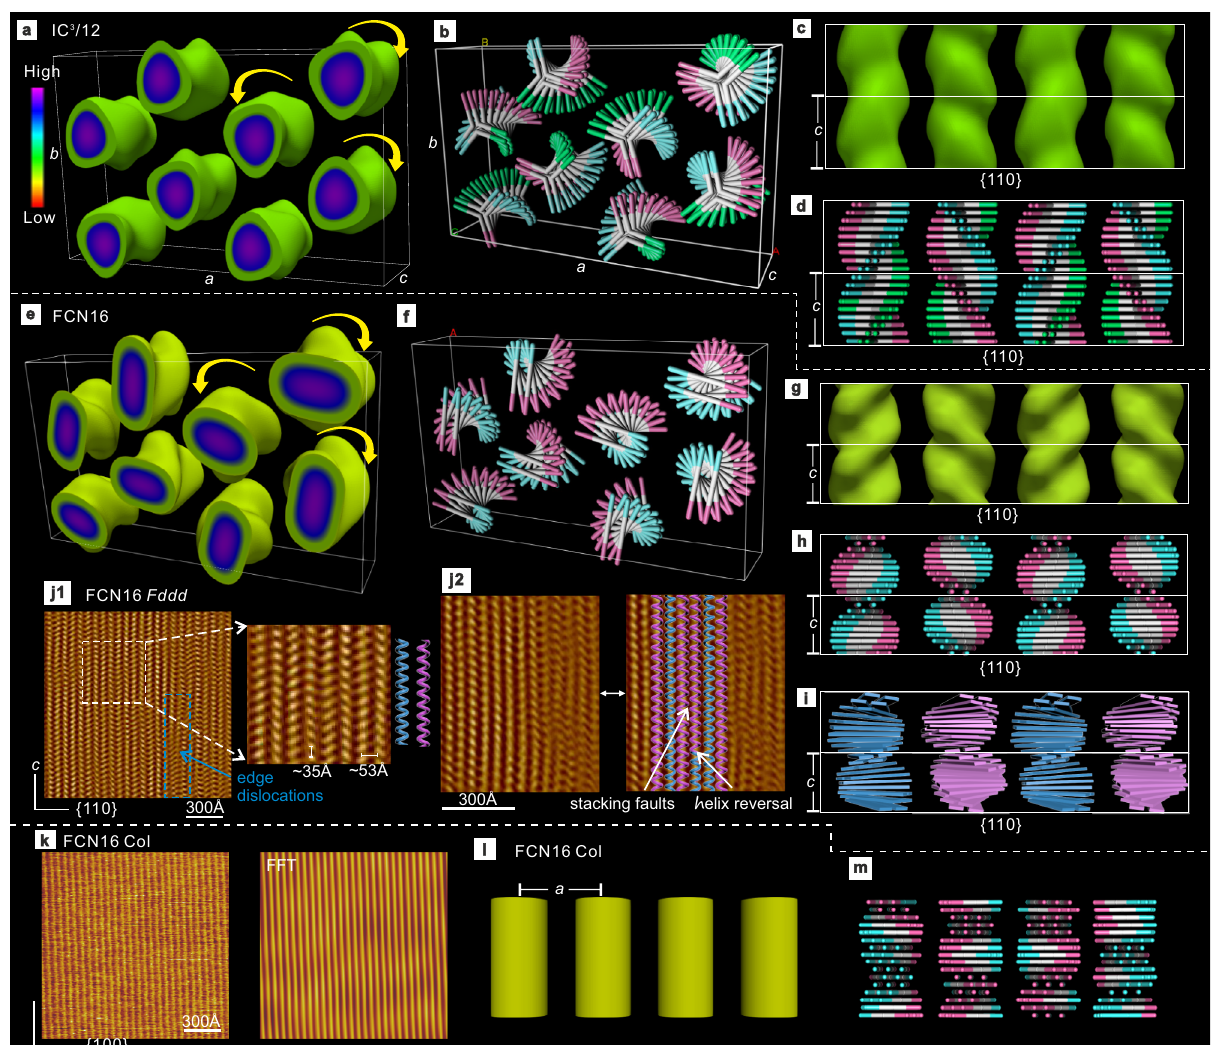
Fig. 5 ED maps, schematic models, and AFM images. ED maps and stylized models of Fddd phase of ( a – d ) IC 3 /12 and ( e – h ) FCN16, and ( l , m ) of the Col phase of FCN16. a , c , e , g 3D maps with high ED regions (aromatic) enclosed within the isoelectronic surface (see also Supplementary Movies 1 and 4). b , d , f , h Schematic models of winding rod-like molecular cores ( “ staircases ” , see also Supplementary Movies 2, 3, 5, and 6). The two or three core end groups are colored differently for clarity. The high positional order is grossly exaggerated. For easier comparison of IC 3 /12 and FCN16 structures, the origin of the IC 3 /12 unit cell has been shifted along b axis by b /4; while IC 3 /12 columns are sitting on 2/1 helical axes, those of FCN16 are on the twofold rotation axes (see Supplementary Fig. 14). c , d , g , h View along b axis. i A more realistic model of h taking account of the 8° molecular tilt. j AFM of Fddd phase of FCN16 recorded at 50 °C (Fourier- fi ltered height image). The enlarged area shows alternating left- and right-handed columns; stacking faults of mismatched chirality and a helix reversal are indicated in j2 . k original AFM image and inverse FFT of Col phase of FCN16. l ED map (time/space average by SAXS) and m , random twist model (an instantaneous arrangement) of Col phase of